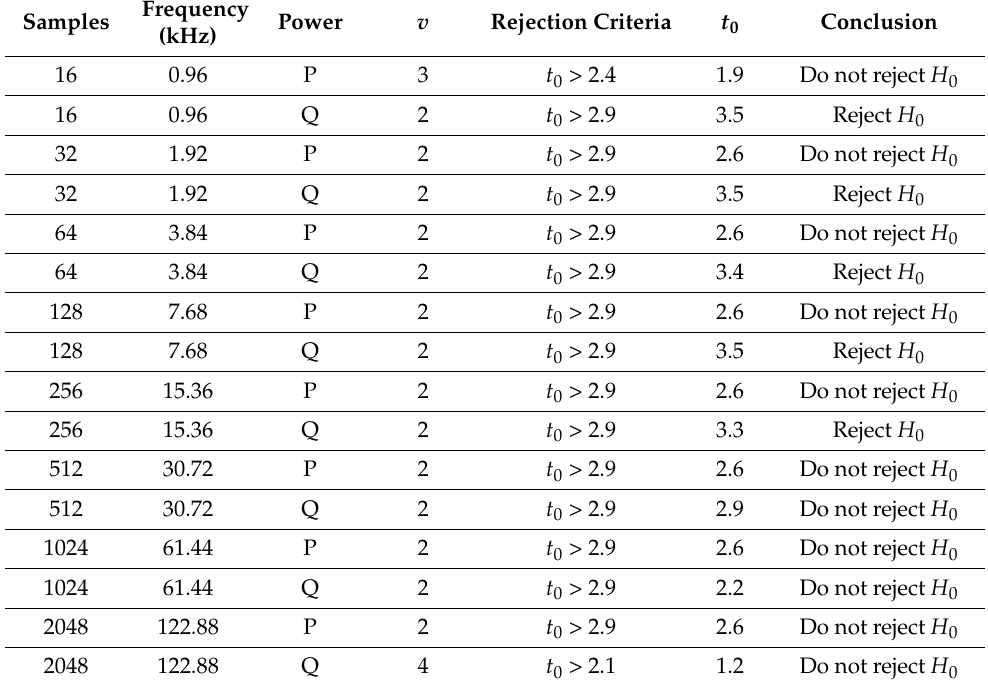
Table 6. Hypothesis test for resistive loads.